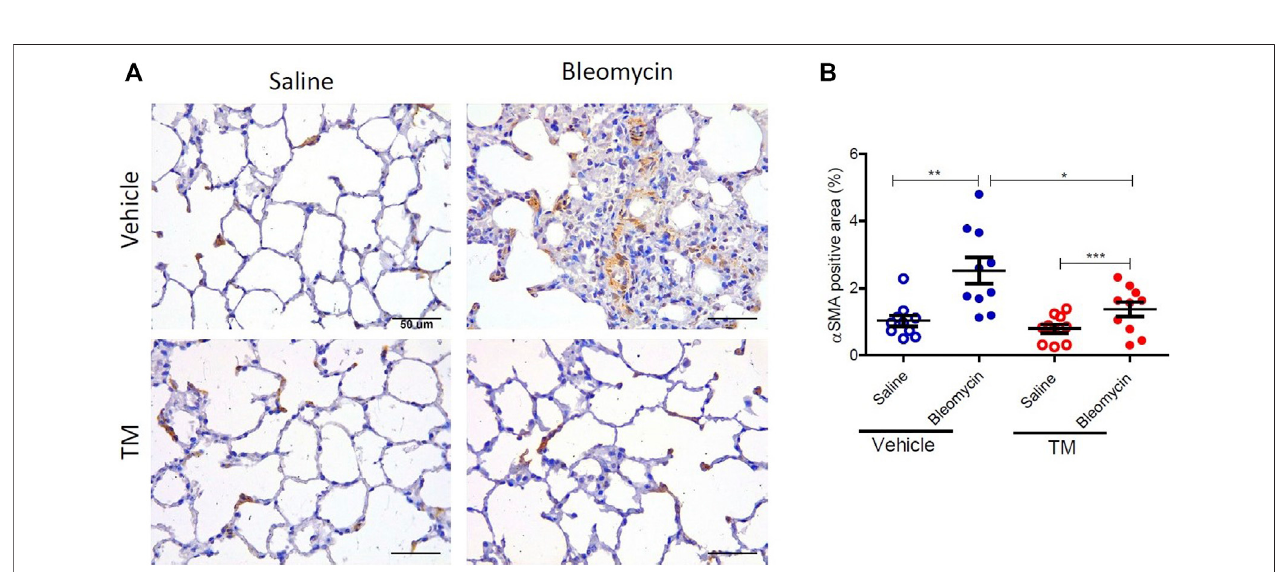
FIGURE 9 | TM treatment signi fi cantly reduces bleomycin-induced activated myo fi broblasts. (A) Representative photomicrographs of differentially treated lung tissuesectionsimmuno-stainedwithananti – α SMAantibodytoidentifycontractilemyo fi broblasts.Inbleomycin-infusedsegments,inthevehicle-controltreatedanimals, more α SMA-positive cellswere present in fi brotic remodeled areas compared tosaline-infused segmentsofthe same animals.In contrast,bleomycin-infused segments of sheep that were treated with TM had comparable staining with saline-infused segments. The α SMA-positive area was quanti fi ed in (B) . Signi fi cance was analyzed using a paired t -test between saline- vs . bleomycin-infused segments from the same animals and an unpaired t -test between segments from different animals (vehicle vs . TM treated animals), n (cid:1) 10, * p < 0.05, ** p < 0.01, *** p < 0.001. Scale bars (cid:1) 50 µm.